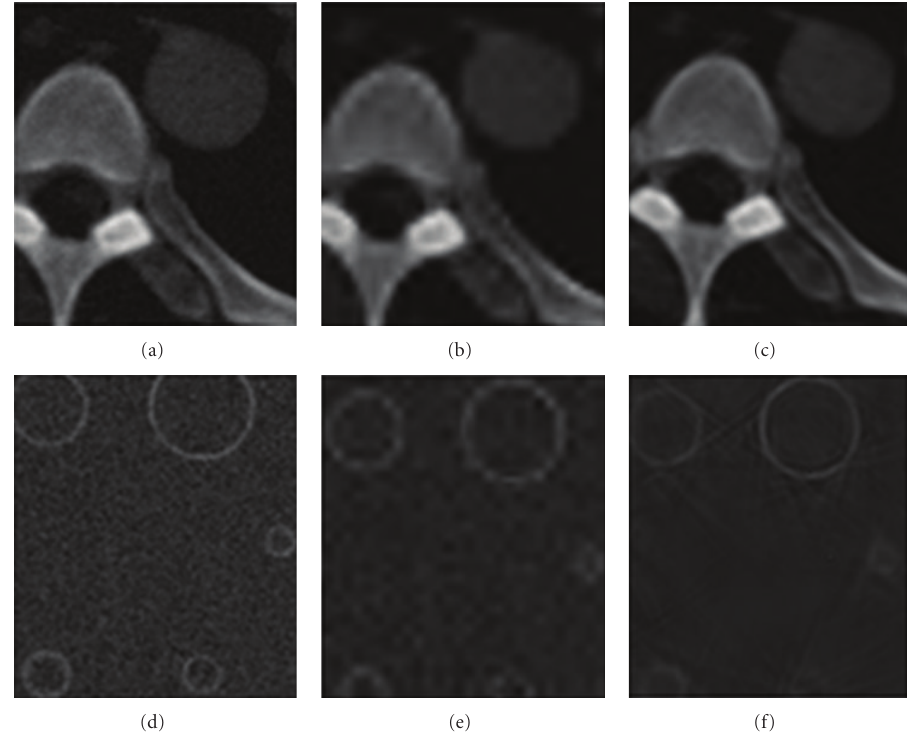
Figure 17: MRA for image denoising. (a, d) Noisy images. (b, e) Wavelet. (c, f) Curvelet.